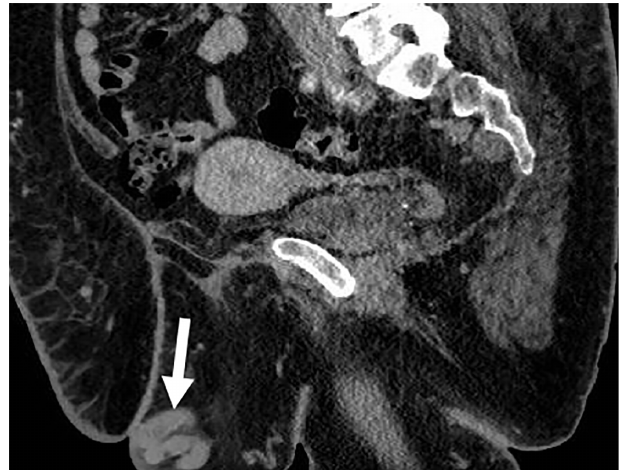
Image 1. Sagittal cross-section of computed tomography of abdomen and pelvis with intravenous contrast demonstrating dilated pelvic veins (arrow) near the mons